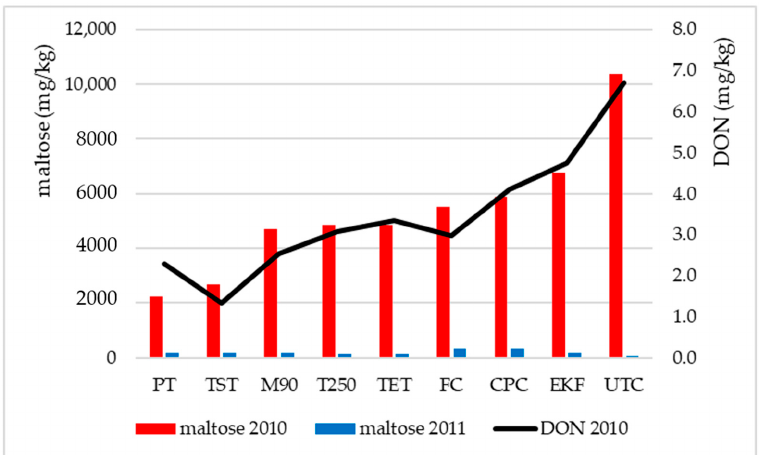
Figure 1. The average total amounts of maltose and DON (deoxynivalenol) toxin content across cultivars in fungicide-treated flour samples; 2010–2011. DON content in 2011 was below detection limit in all treatments.